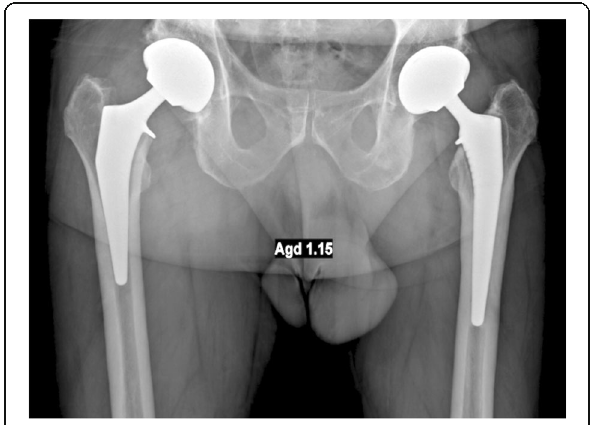
Fig. 1 Postoperative anteroposterior radiograph of both implants, implanted in the same patient. The Symbol (shortened stem) is on the left and the Hype (standard stem) on the